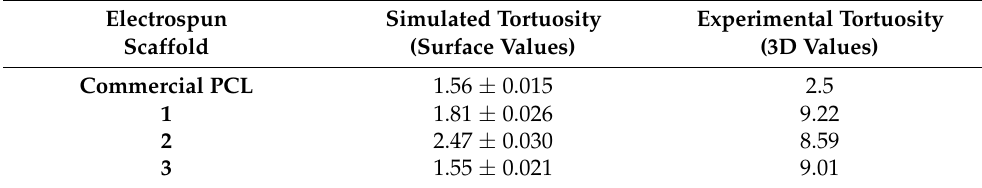
Figure 10. Scatter plots comparing the experimental and estimated results for ( a ) porosity, ( b ) diffusion coefficient in water, and ( c ) diffusion coefficient in CCM. Table 7. Calibration for estimated and experimental tortuosity at 37 °C.